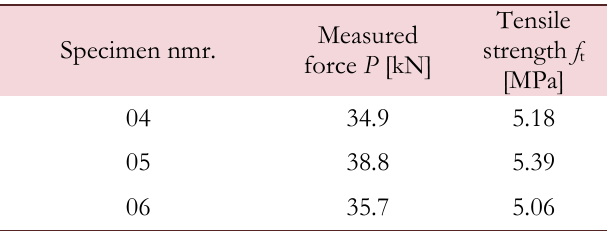
Table 4: Measured forces and calculated tensile strength from eq. (1) for unnotched Brazilian disc.